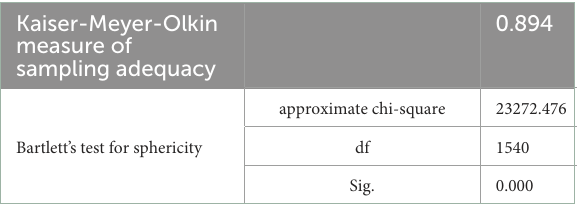
TABLE 3b KMO and Bartlett’s test for variables.